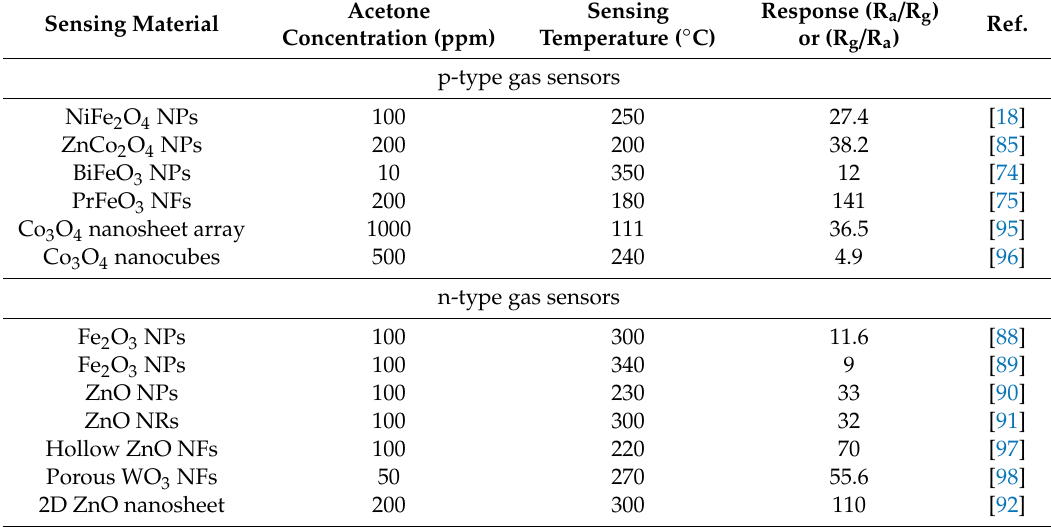
Table 1. A summary of pristine acetone gas sensors reported in the